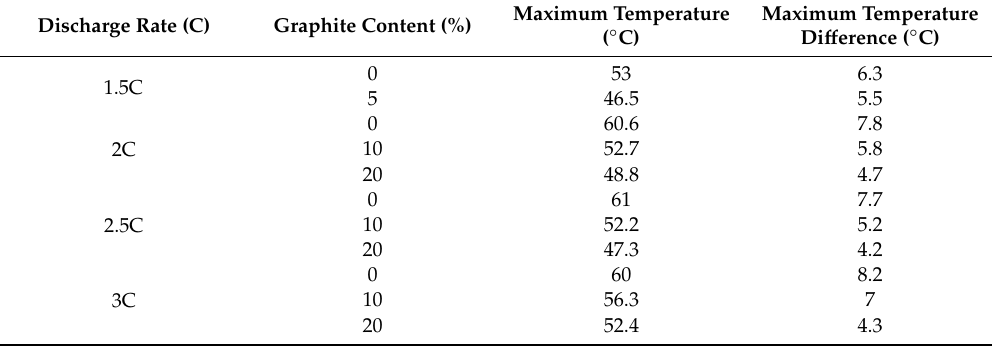
Table 5. The maximum temperature and the highest temperature di ff erence of battery surface when CPCM with di ff erent EG contents are used for cooling the battery under di ff erent discharge rates. Discharge Rate